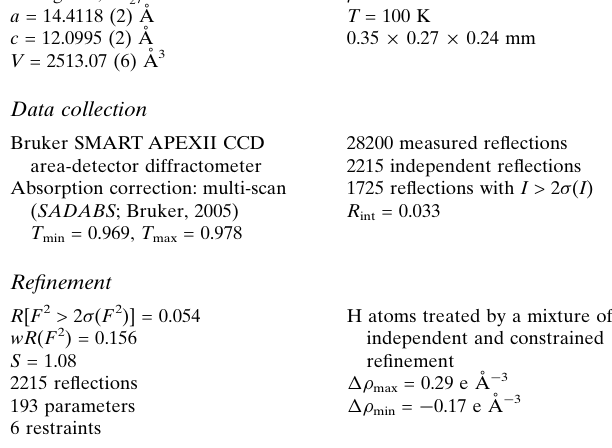
28200 measured reflections 2215 independent reflections 1725 reflections with I > 2 (cid:2) ( I ) R